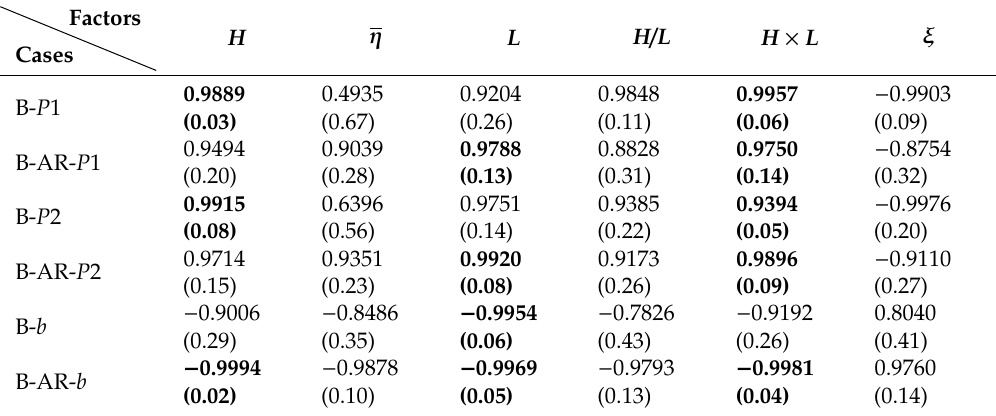
Table 8. The Pearson’s linear correlation coe ffi cients of hydrodynamic factors and model parameters under regular waves with significant level in parentheses ( H is the wave height at W6, and L is calculated by local water depth and period at W6; bold format indicates correlation coe ffi cients with relatively low significant level meaning significant